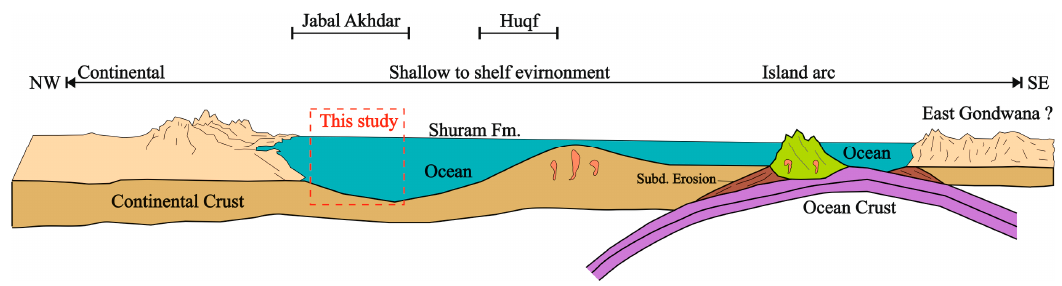
Figure 5. Schematic simplification of the tectonic setting of northeastern Oman. Fm. = Formation.